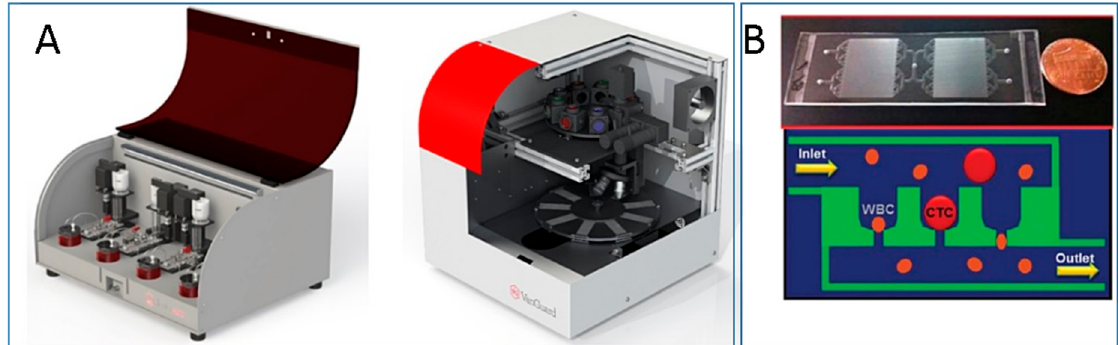
Figure 2. The “Celsee” system, able to process blood samples and perform image analysis ( A ). Microfluidic setup and scheme of the mechanism of CTCs capturing with inlet and outlet for pumping blood samples and reagents through the device ( B ). Modified with permission from [59].